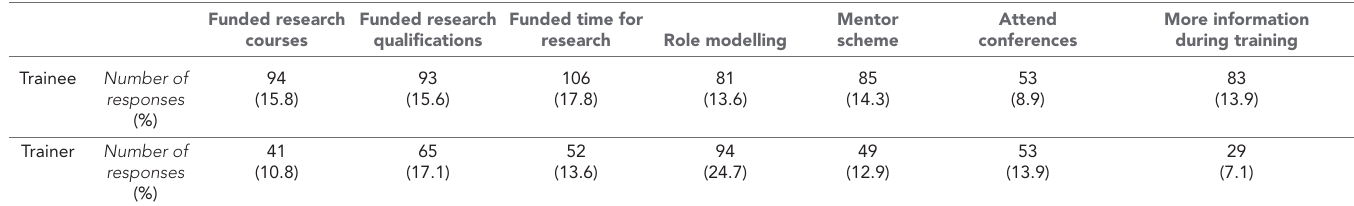
Table 5 Factors influencing research